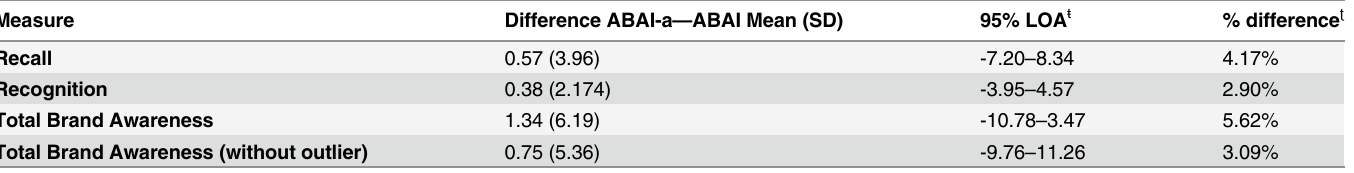
Table 4. Consistency between responses for the ABAI and